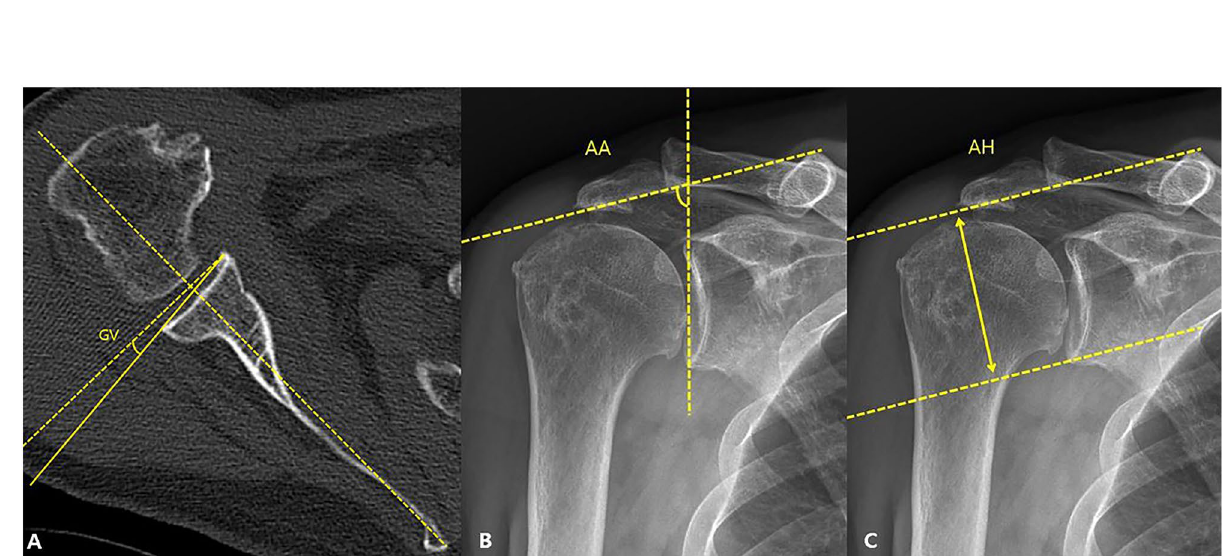
Figure 4. ( A ) glenoid version ( B ) acromial angulation ( C ) acromial